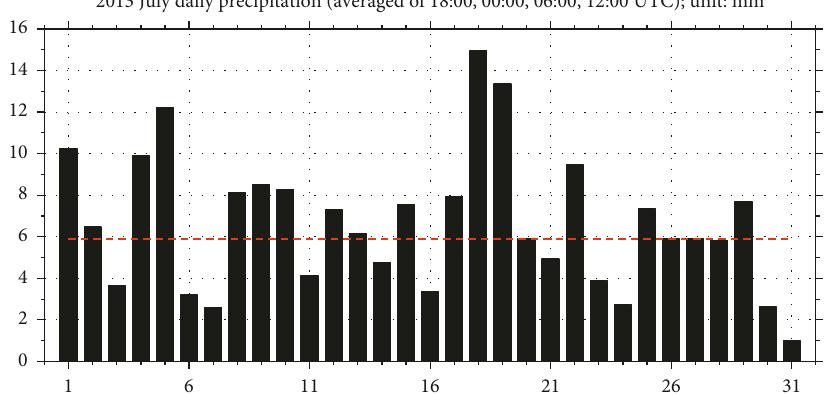
Figure 2: Time series of daily precipitation (unit: mm) averaged over Sichuan Province from 1 to 31 July in 2013 using the gauge-based precipitation data. The red line shows the climate mean (1981–2010) of July precipitation value (5.89 mm) over the Sichuan Province.